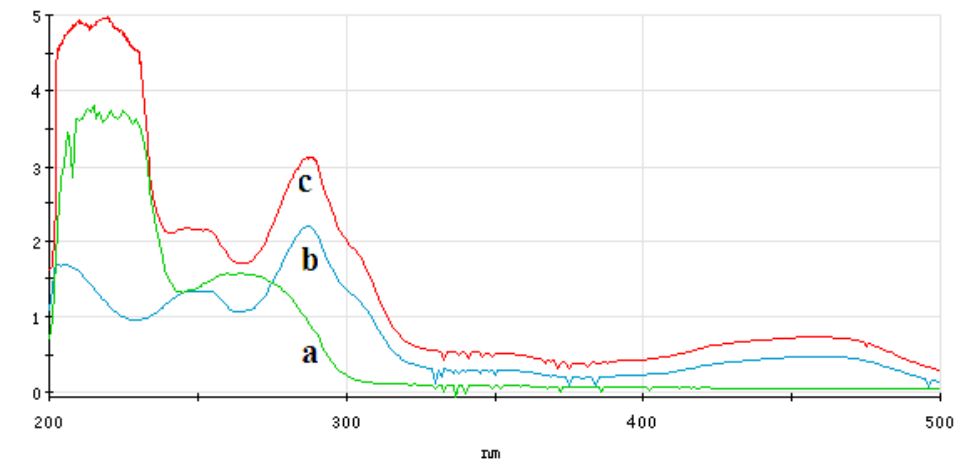
Figure 10. UV-Vis spectrum of ECL probe (( a ) UV-Vis spectrum of phage displayed antibody; ( b ) UV-Vis spectrum of Ru(bpy) 32+ -NHS ester; ( c ) UV-Vis spectrum of Ru(bpy) 32+ -labeled phage displayed antibody).